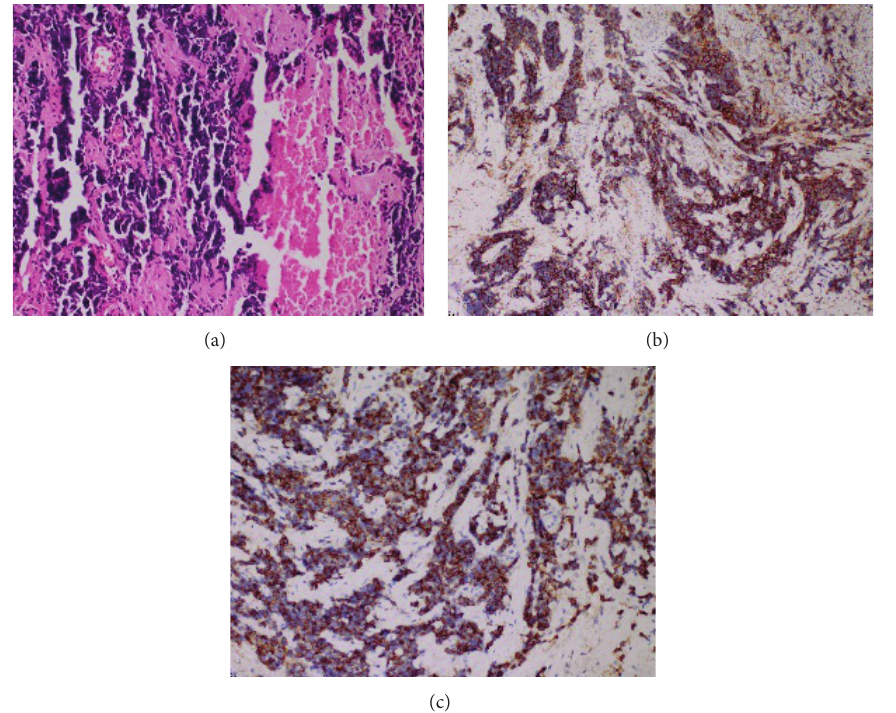
Figure 3: (a) Hematoxylin and eosin staining showing small cells, round to fusiform in shape with scanty cytoplasm, fine granular nuclear chromatin, and absence of nucleoli. Note the necrosis and crush artifact (original magnification × 200). The tumor cells were immunoreactive for (b) pancytokeratin and (c) CD56 (original magnification ×